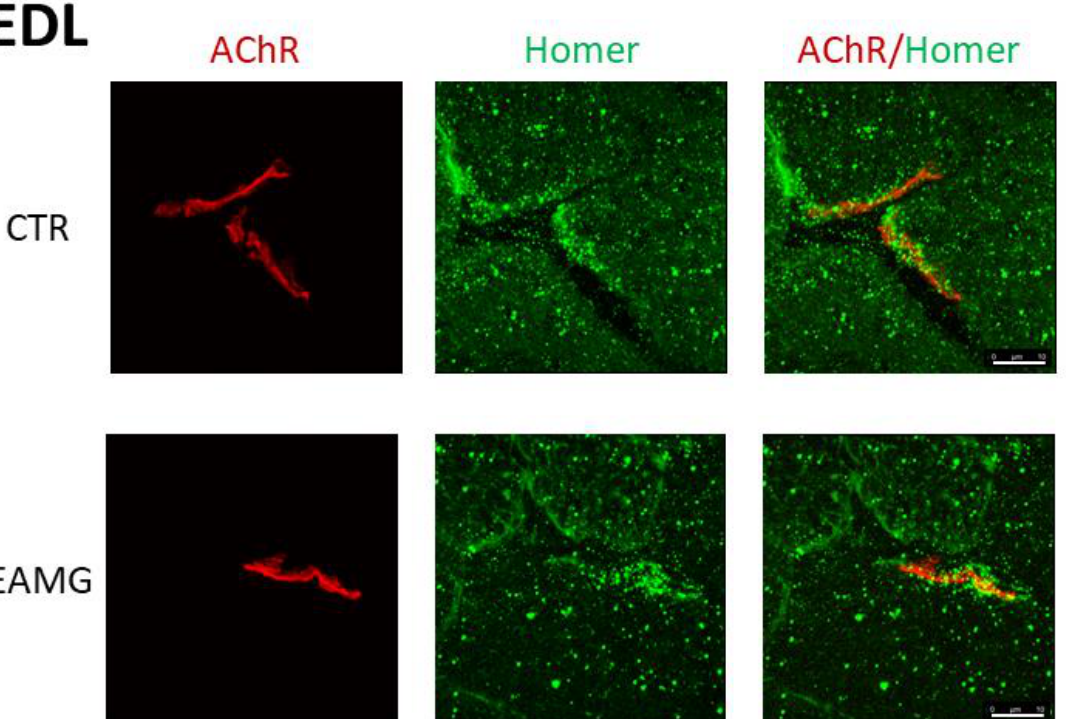
Figure 5. Representative immunohistochemical staining of GAS and EDL muscle endplates and endplate-adjacent Homer protein. For each image block (GAS, EDL) upper panel CTR, lower panel EAMG group. From left to right is shown nAChR-staining ( red ), Homer staining ( green ) and a merged image of both staining. No significant changes between CTR and EAMG are observed in 3D analysis in neither EDL nor GAS in Homer endplate staining. Magnification bar = 10 µm.